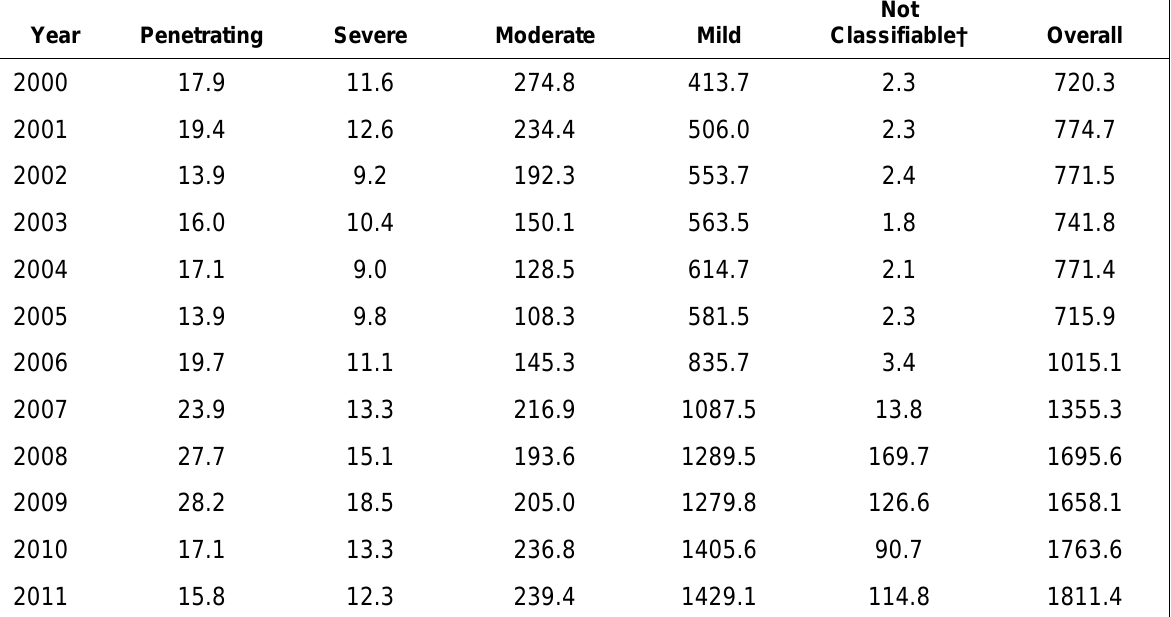
Table 6. Estimated Annual Rates* of TBI among Active-Duty U.S. Military Service Members by TBI Severity,